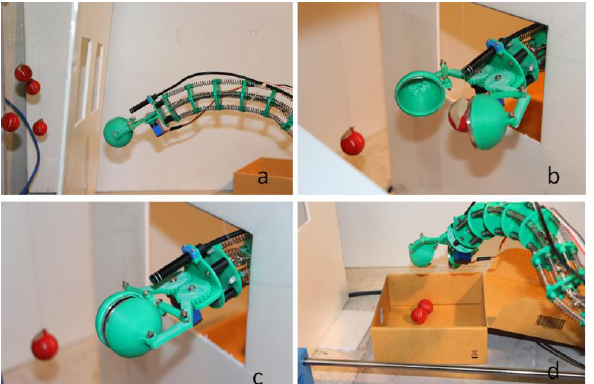
Figure 24. Tomato harvesting procedure. ( a ) scanning and reaching for the tomato, ( b ) grasping the tomato, ( c ) separating the tomato, ( d ) putting it in the